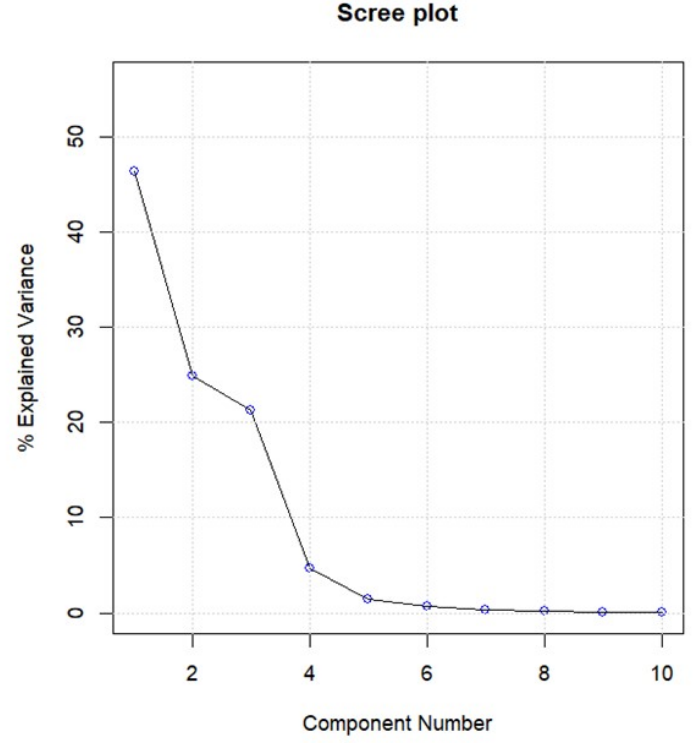
Figure 5. Scree plot of B 18,521 data matrix.